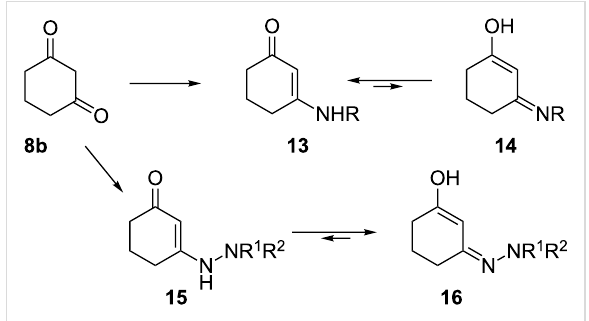
Scheme 4: Formation of mono-imines and mono-hydrazones of 1,3- cyclohexanediones and tautomeric equilibrium between enol-imine and keto-enamine